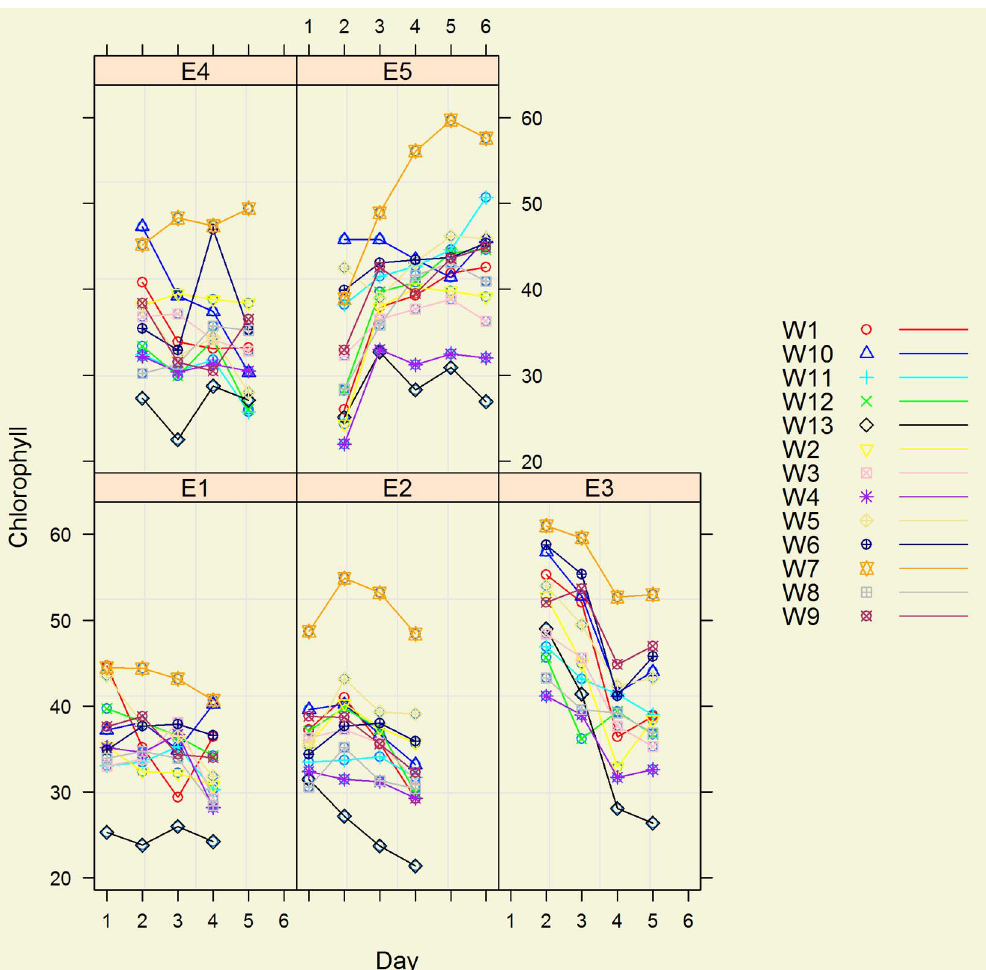
Figure 3. Wheat genotypes (W1–W13) SPAD units (Chlorophyll) in five environments (E1 Early sown High nutrition, E2 Early sown, Low nutrition, E3 Late sown, High nutrition, E4 Late sown low nutrition & E5 Glasshouse) taken on up to 5 days (1, 2, 3, 4, 5) in experiment 2.